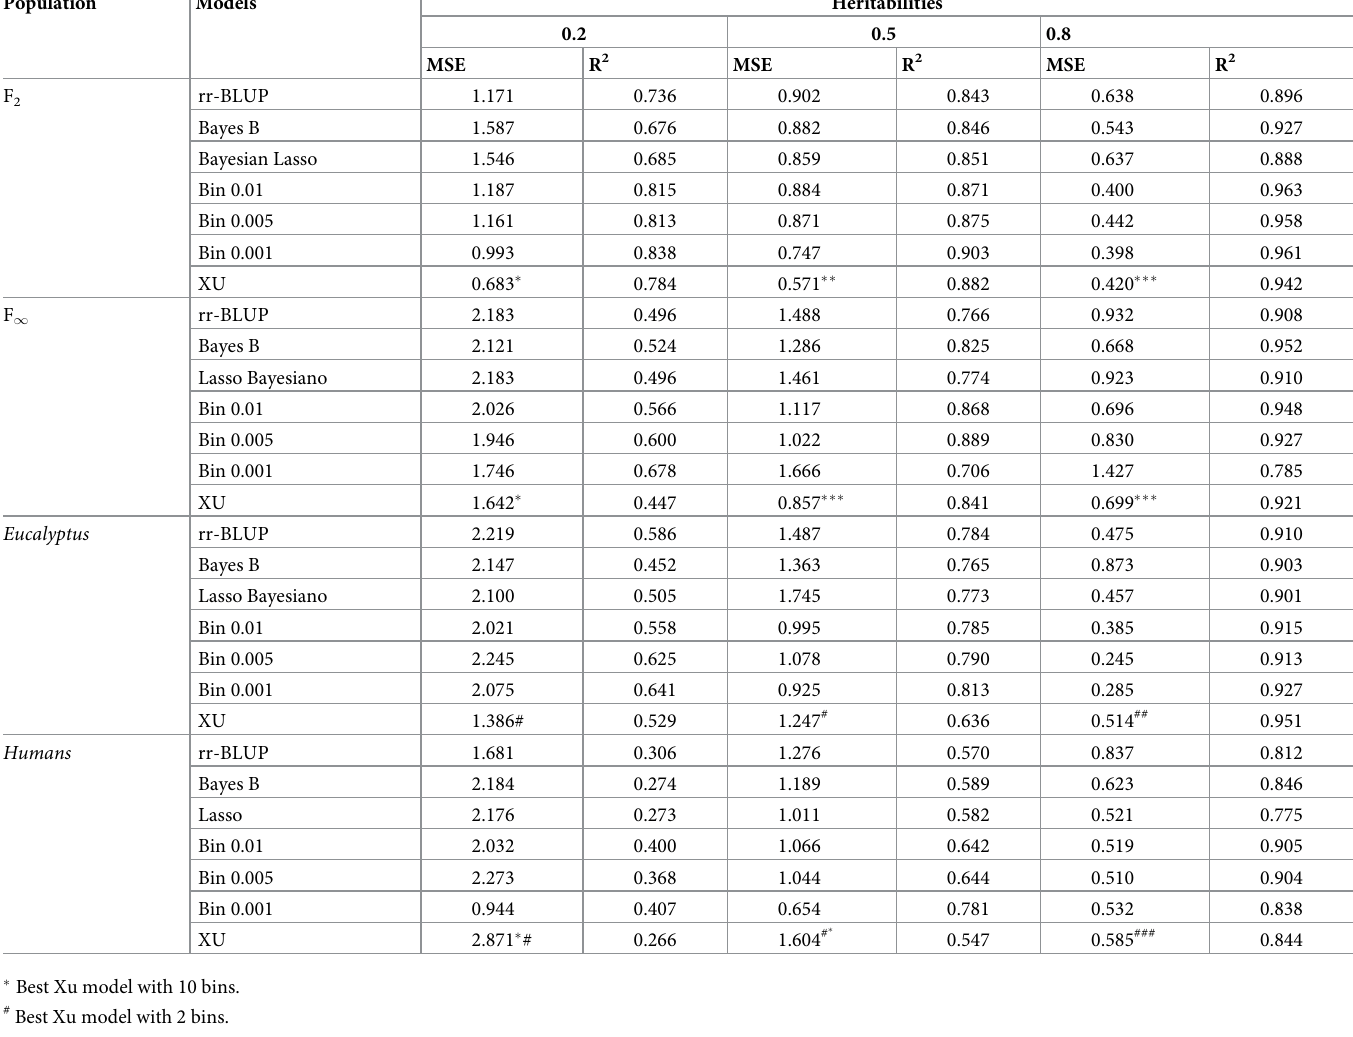
Table 1. Mean Square Error (MSE) and coefficient of determination (R 2 ) of the RR-BLUP, Bayes B, Bayesian Lasso, Bin 0.01, Bin 0.005 e Bin 0.001 models, for the three heritabilities considering three population structures. Population Models